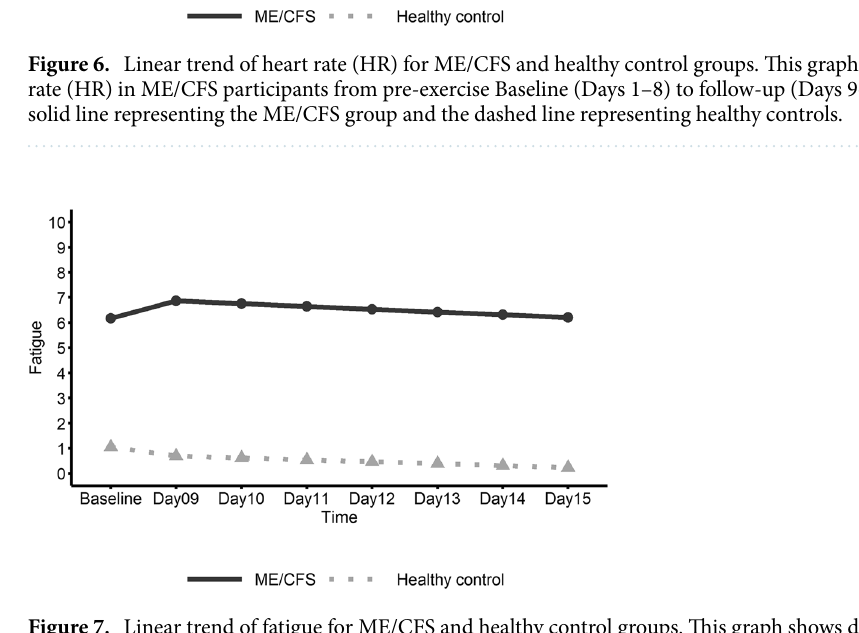
Figure 7. Linear trend of fatigue for ME/CFS and healthy control groups. This graph shows daily fatigue ratings in ME/CFS and healthy control groups from pre-exercise Baseline (Days 1–8) to follow-up (Days 9–15) with the solid line representing the ME/CFS group and the dashed line representing healthy